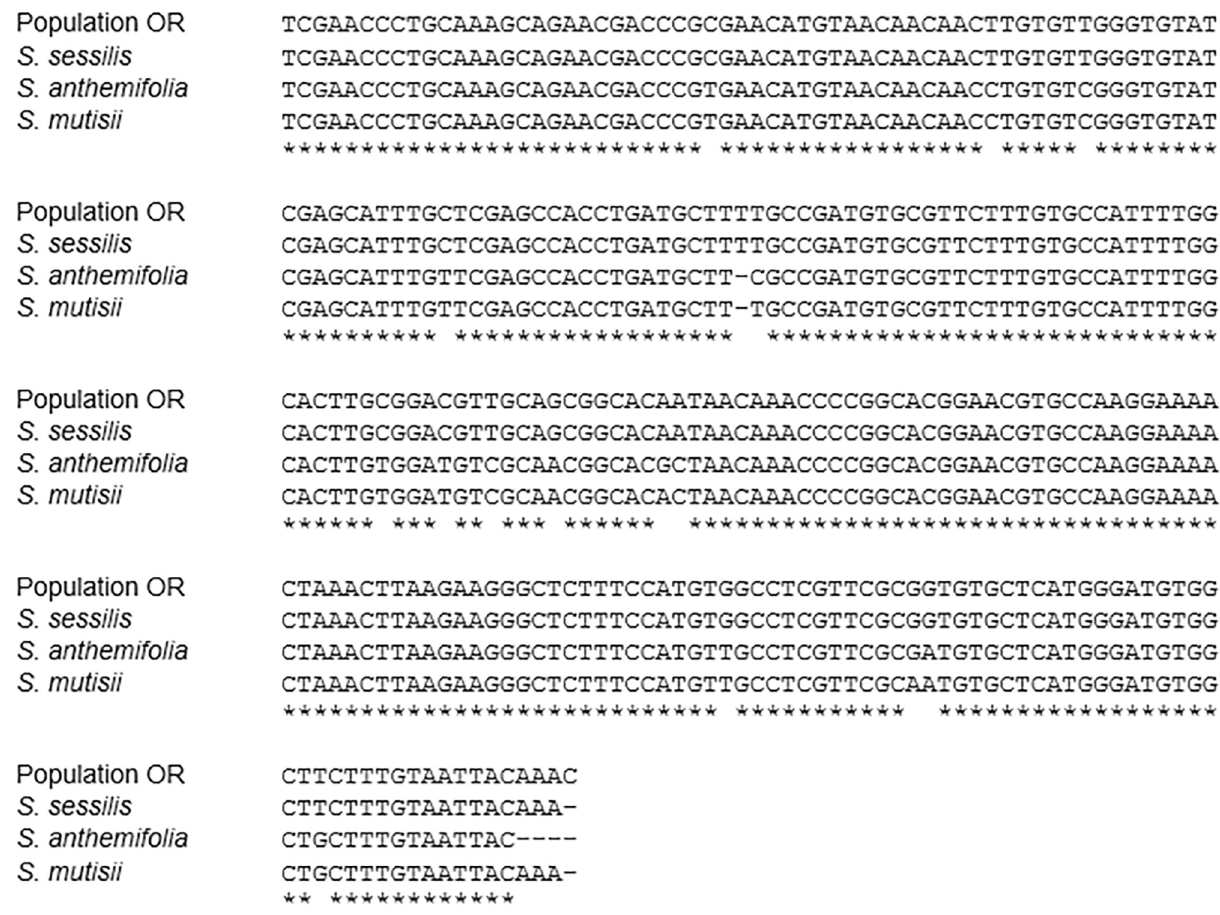
Fig 4. Sequence alignment of the internal transcribed spacer 1 (ITS1) regions of clopyralid-resistant population (OR), S . sessilis , S . anthemifolia , and S . mutisii . Hyphens (-) denote alignment gaps and asterisks donates residues conserved in all sequences.